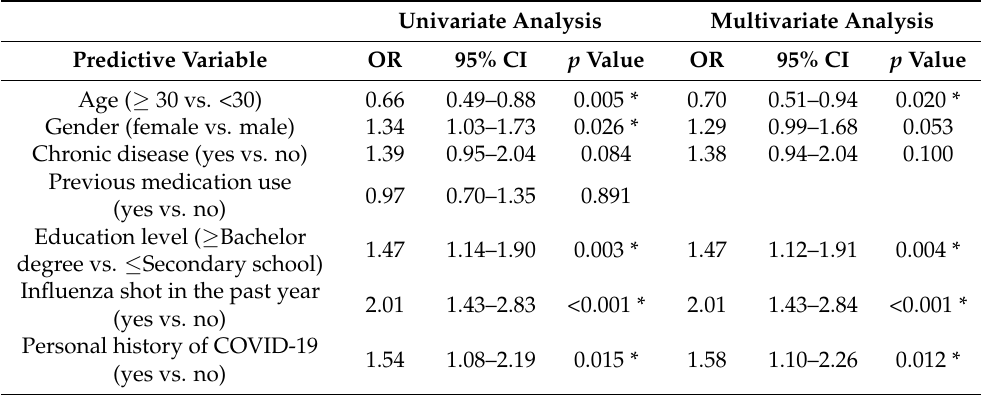
Table 4. Univariable and multivariable logistic regression analysis of influencing factors for positive perception to COVID-19 vaccination. * p <